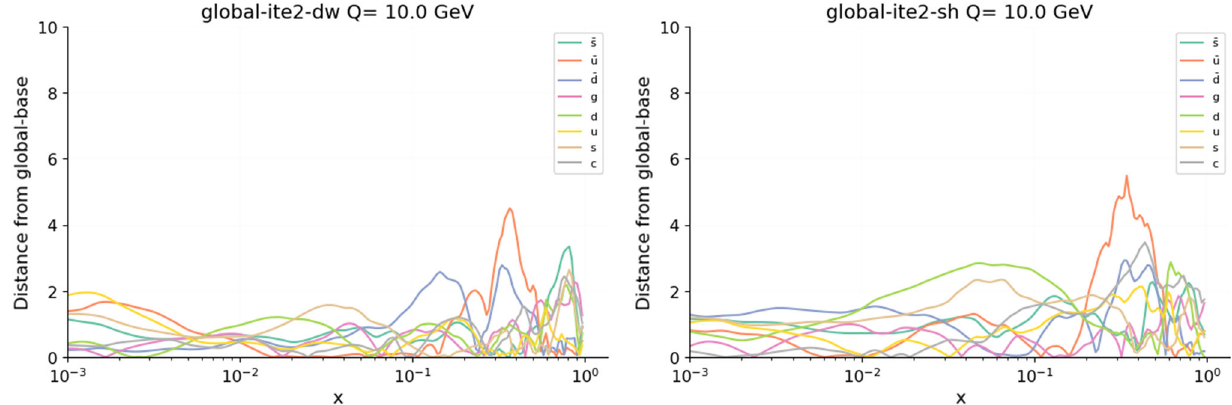
x at a representative scale for the deuteron dataset, Q = 10 GeV. The ReportEngine software [36] was used to generate this